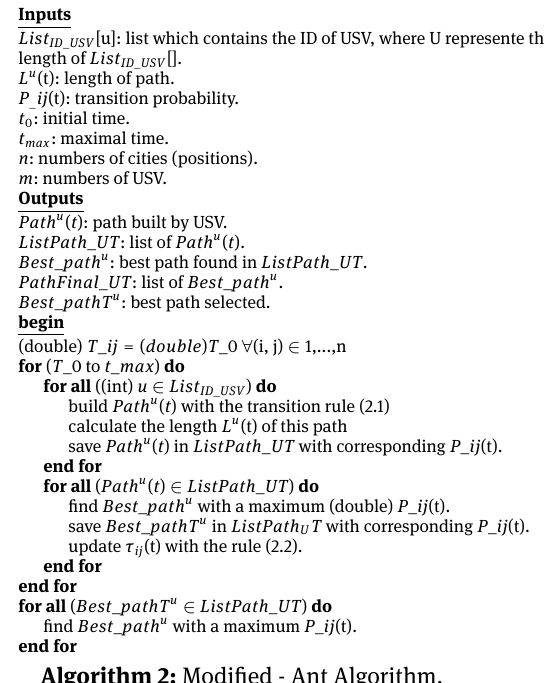
Algorithm 2: Modified - Ant Algorithm.